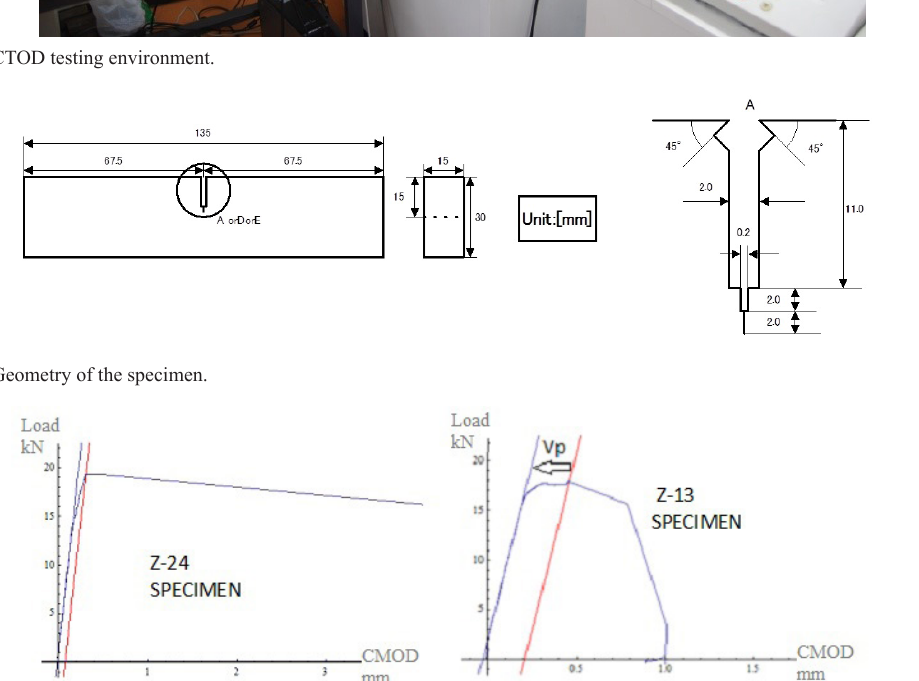
Figure 5. Material behavior graphics (Load x Crack Mouth Opening